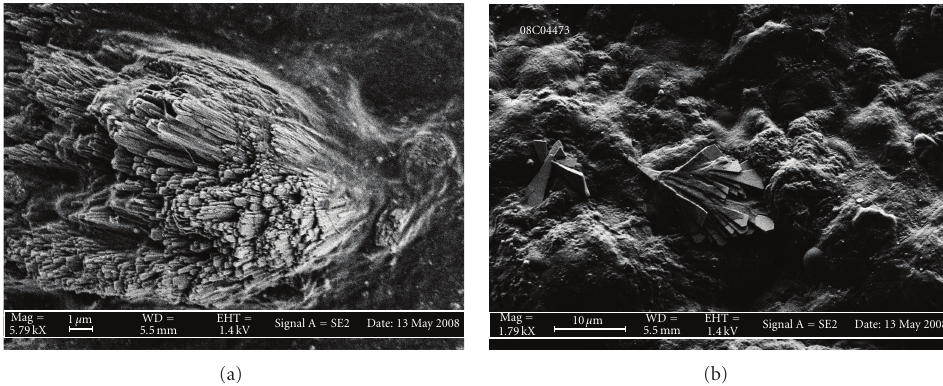
Figure 2: Scanning electron micrographs of crystalline ultrastructures on the surface of inconspicuous valve areas in patients su ff ering from CAVD. (a) Bundles of faceted microrods are inserted into the leaflet surface. Magnification × 5790. (b) Surface areas are covered with round-shaped or sphere-like, flat structures adherent to the leaflet surface. Note the additional small bundle of plate-like facetted microrods (center). Magnification × 1790.